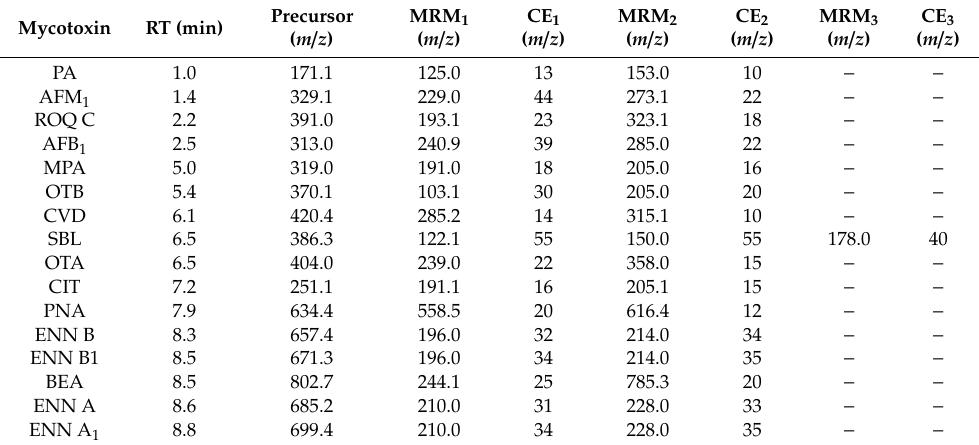
Table 1. Instrumental parameters of LC-MS / MS